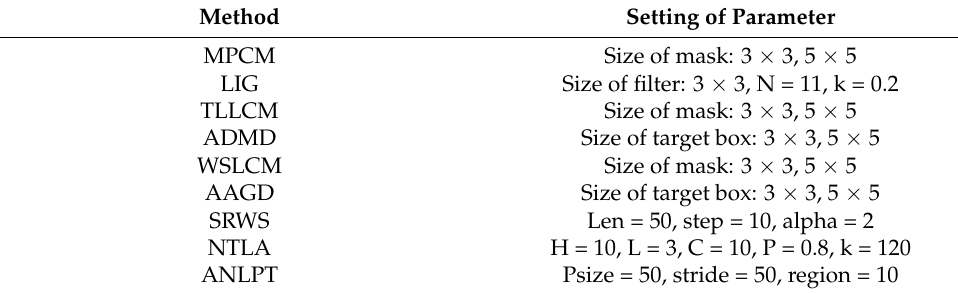
Table 6. Summary of parameters.